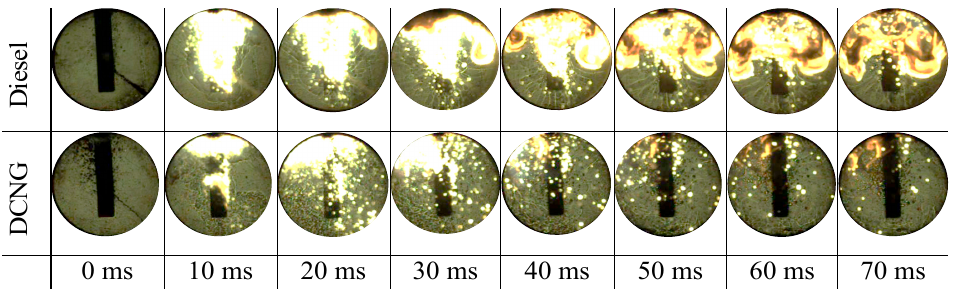
Figure 5. Diesel and 60/40 diesel/CNG mixture combustion sequence.